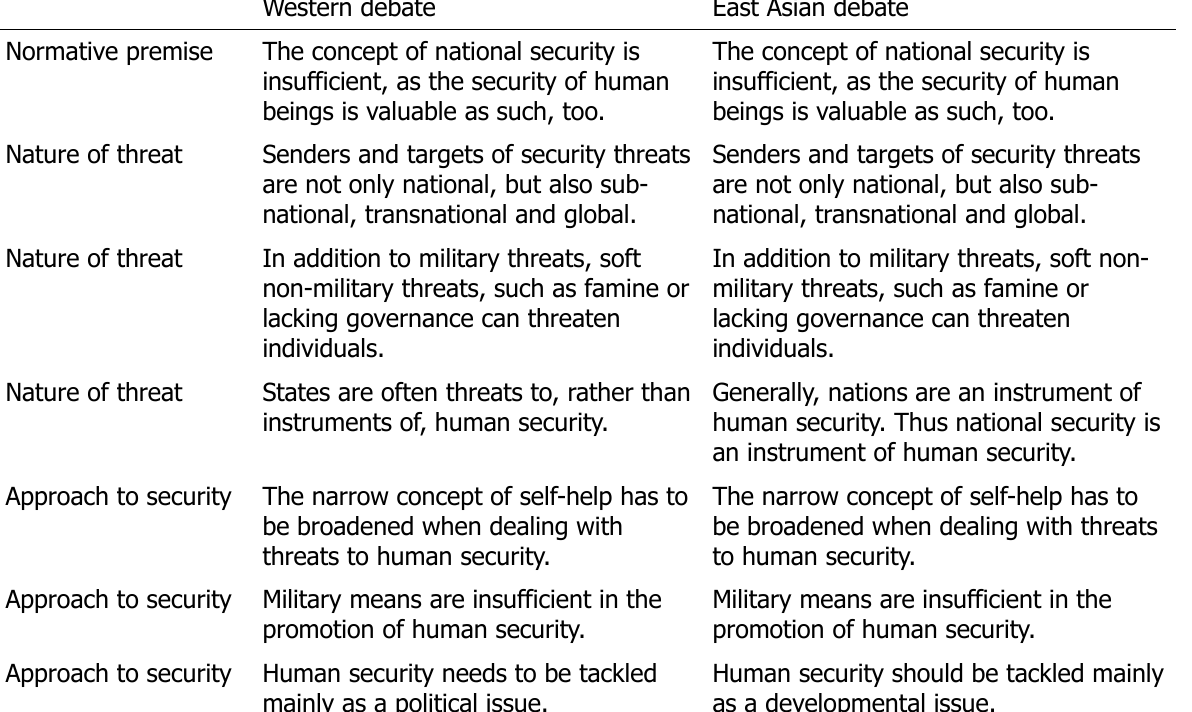
Table 1. Common and Differing Positions on Human